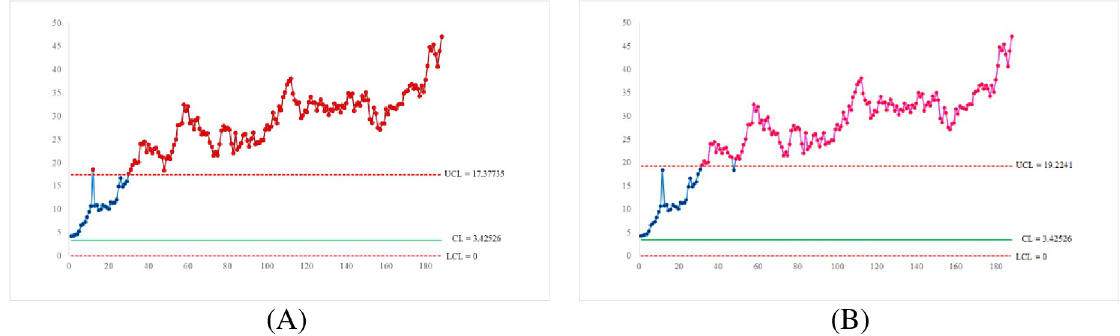
Fig 3. Detecting shifts the mean on the long-memory SARFIMAX(1, 0.496151, 1 1) 12 process based on real data on an upper-side CUSUM control chart for (A) ARL 0 = 370 and (B) ARL 0 = 500. CL, center line; UCL, upper control limit; LCL, lower control limit.